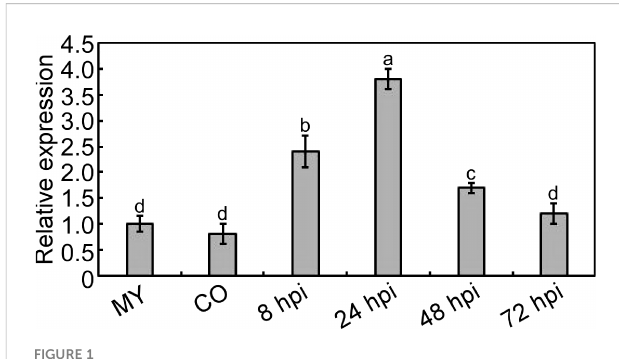
FIGURE 1 Transcription analysis of MoPDX1 at different stages of M. oryzae . Total RNA was extracted from the mycelium (MY) stages, conidia (CO) stages, and infectious stages at 8, 24, 48, and 72 hours post inoculation (hpi), respectively. The RNA was reverse transcribed and then quanti fi ed by q-RT PCR. The transcript level of MoPDX1 at the mycelium stage was set at 1.0. Experiments were repeated three times with similar results. Error bars represent the standard deviation. Lowercase represent signi fi cant differences (LSD and Student- Newman-Keuls test, p